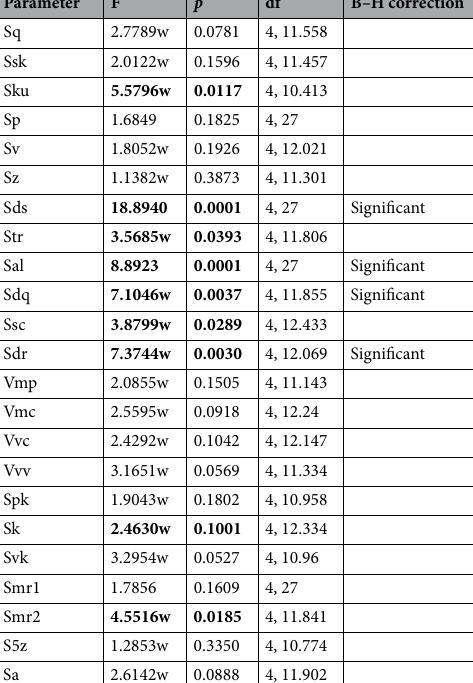
Table 1. Results of ANOVA comparing samples from multiple different individuals with different diets (wild and captive), and samples from multiple sites within a tooth. W indicates Welch ANOVA; significant differences ( P < 0.05) in bold. B–H correction reports the results of a Benjamini–Hochberg procedure (False Discovery Rate 0.05).